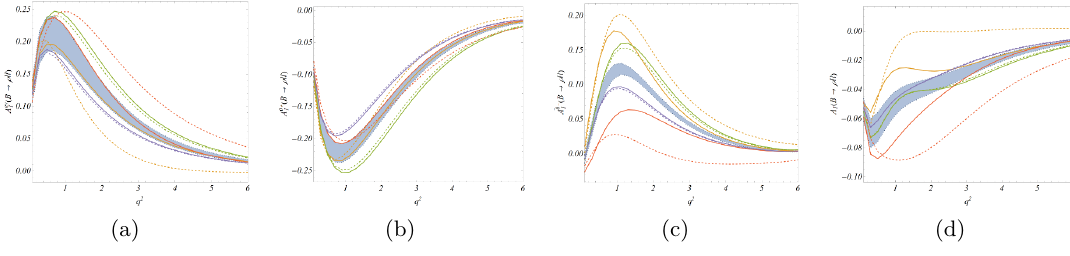
Figure 6 . Isospin asymmetries in B → ρ‘‘ decays measurable at the LHCb.